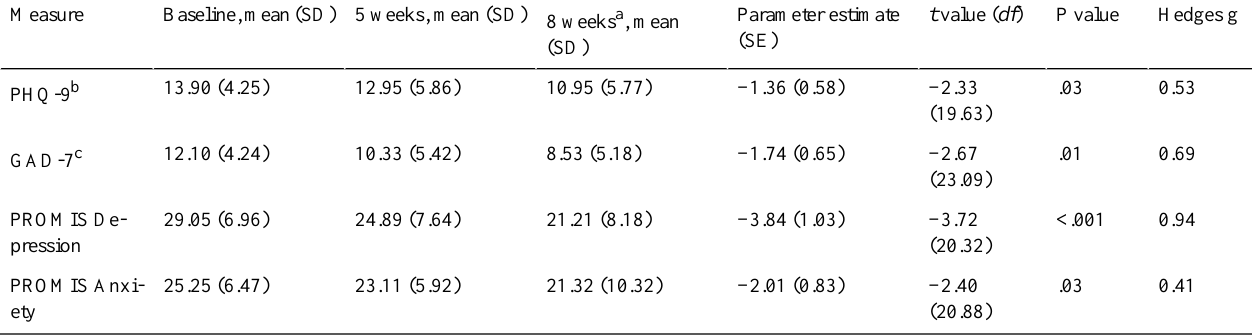
Table 4. Mean assessment scores across timepoints and linear mixed effects models.